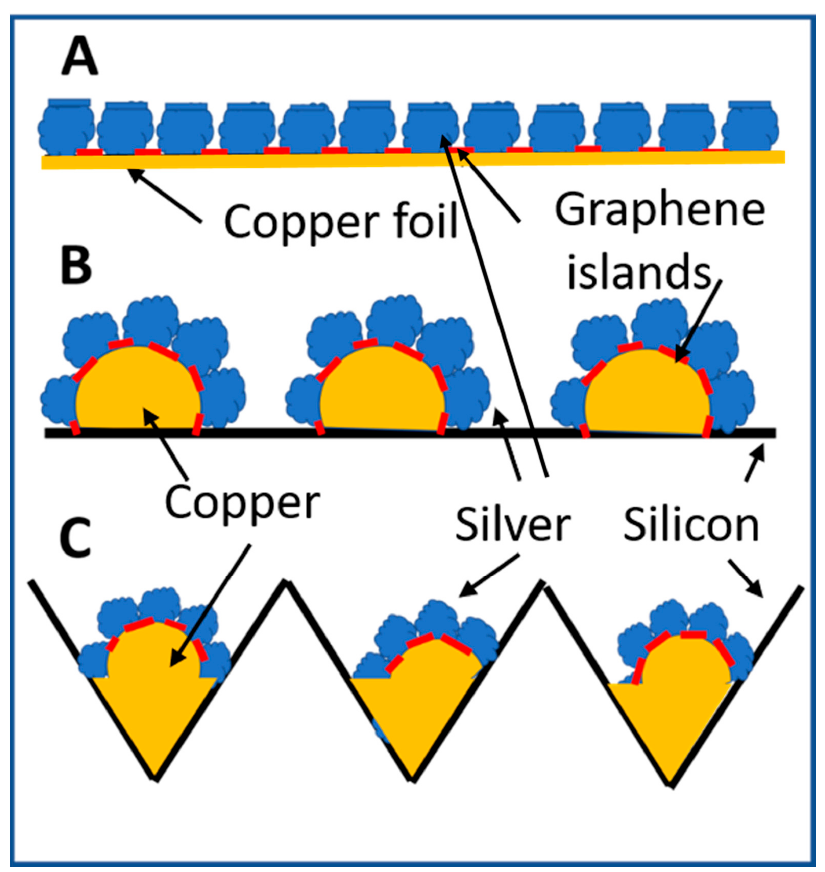
Figure 2. Schematic diagram of silver nanoparticles grown by nitrate reduction on graphene nano-islands template covered copper surfaces. ( A ) Two-dimensional array of silver nanoparticles deposited on a planar copper surface using graphene nano-islands synthesized on copper by rapid thermal CV technique as a template. The red sections represent the graphene template. ( B ) Thermal annealing of a copper thin film deposited on a planar silicon wafer breaks apart the copper thin films into discrete pieces, which peel off from the silicon surface, melt or deform into discrete three-dimensional copper structures. Graphene nano-islands deposited on the copper structures serve as a template for silver nanoparticles to grow by nitrate reduction in directions perpendicular to the copper surfaces. ( C ) A copper thin film is deposited on a silicon wafer with etched holes. Broken copper thin films melt and solidify at the bottom and on the sidewall of etched holes. Discrete silver nanoparticles are deposited on copper surfaces using graphene nano-islands synthesized on copper surfaces as a template. Table 1. Process Parameters for Etching Holes in Silicon Wafers.